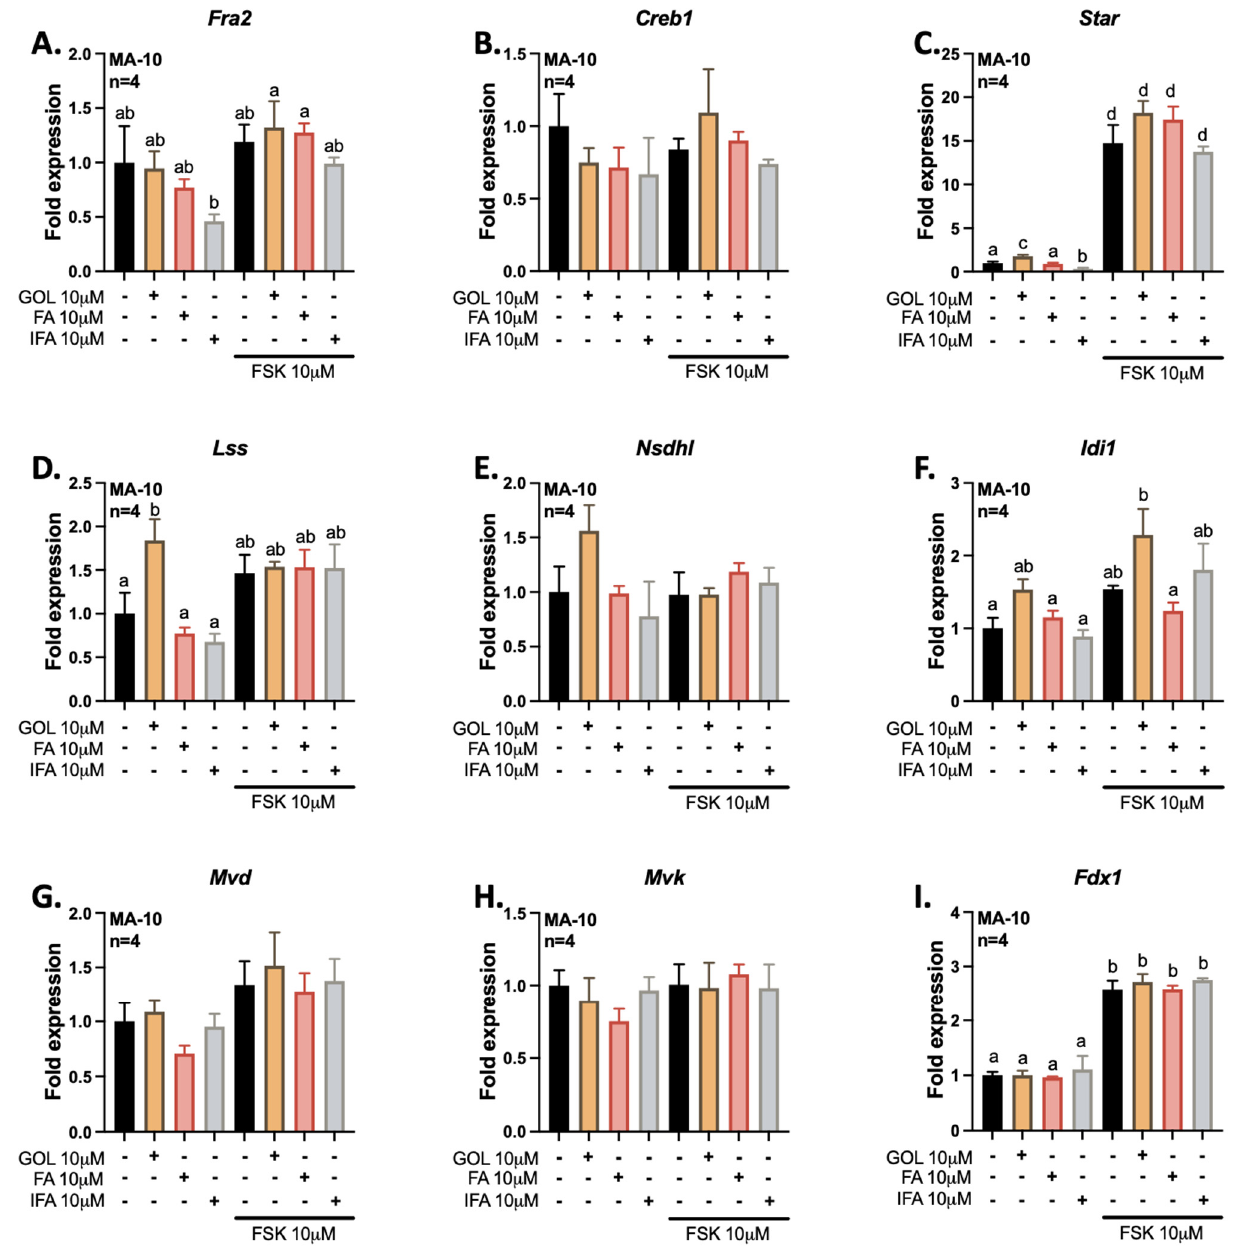
Figure 7. Evaluation of gene expression by quantitative real-time PCR for genes related to the regulation of steroidogenesis and cholesterol biosynthesis. Following treatments of MA-10 Leydig cells with 10 µ M gigantol (GOL), ferulic acid (FA), or isoferulic acid (IFA) in the presence or absence of 10 µ M forskolin (FSK) for 4 h, total RNAs were extracted, followed by reverse transcription and quantitative real-time PCR assays for ( A ) Fra2 , ( B ) Creb1 , ( C ) Star , ( D ) Lss , ( E ) Nsdhl , ( F ) Idi1 , ( G ) Mvd , ( H ) Mvk and ( I ) Fdx1 gene expressions. Results are normalized using Rpl19 reference gene expression and presented as fold expression relative to control (nontreated cells, DMSO only) ( ± SEM). A two-way ANOVA followed by a Holm-Sidak multiple comparisons test was used to analyze data. Different letters indicate significant differences ( p < 0.05).